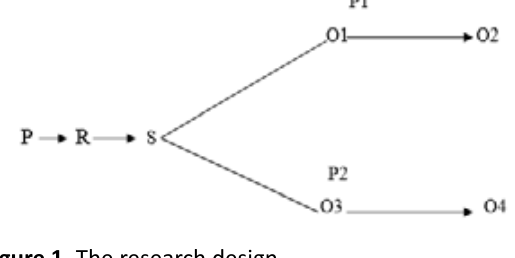
Figure 1. The research